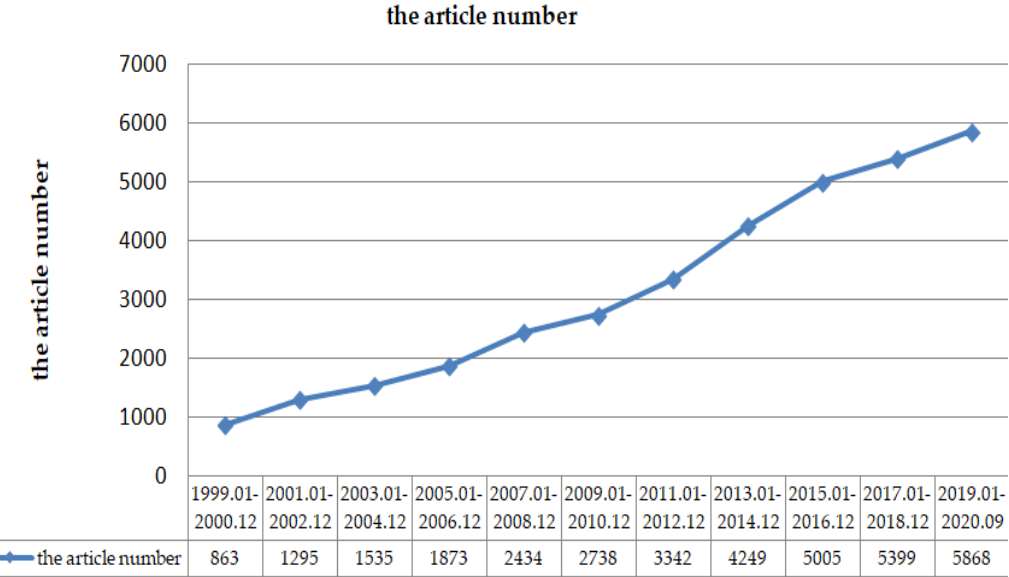
Figure 2. The number of papers published on link prediction.